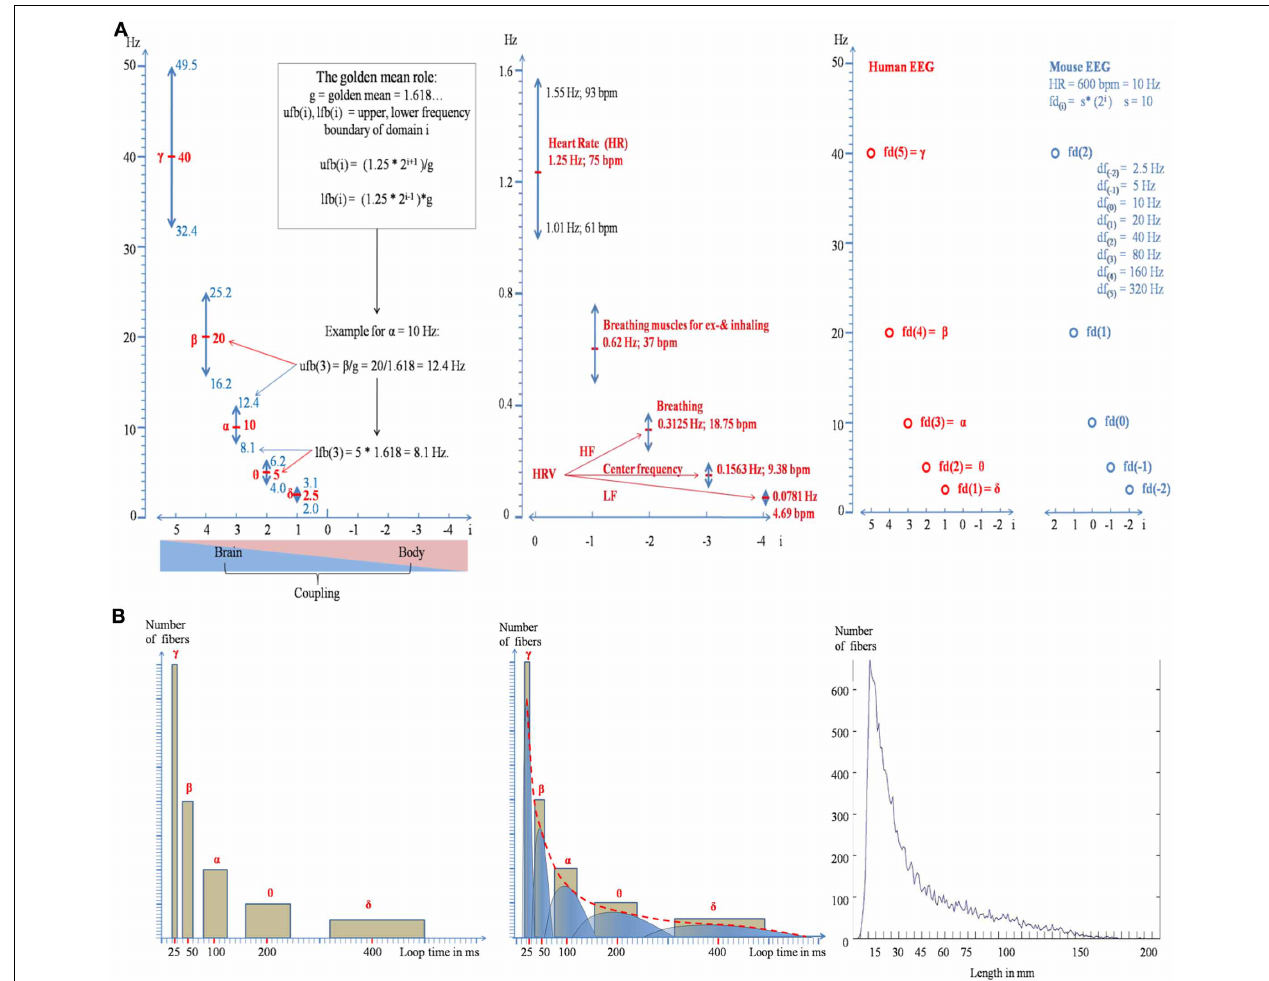
FIGURE 1 | Illustration of the doubling-halving algorithm as described by formula (2a). (A) The distribution of the frequency domains, together with their bandwidths is shown in the left panel for brain oscillations and in the middle panel for body oscillations. The frequency boundaries are calculated according to the “golden mean role”: The upper frequency boundary of domain i is that frequency which is maximally separated from domain i + 1 and the lower boundary is that frequency which is maximally separated from domain i − 1 (see the inset in the left panel for an example). The predicted frequency architecture for a mouse with a heart rate of 600bpm ( = 10Hz) is